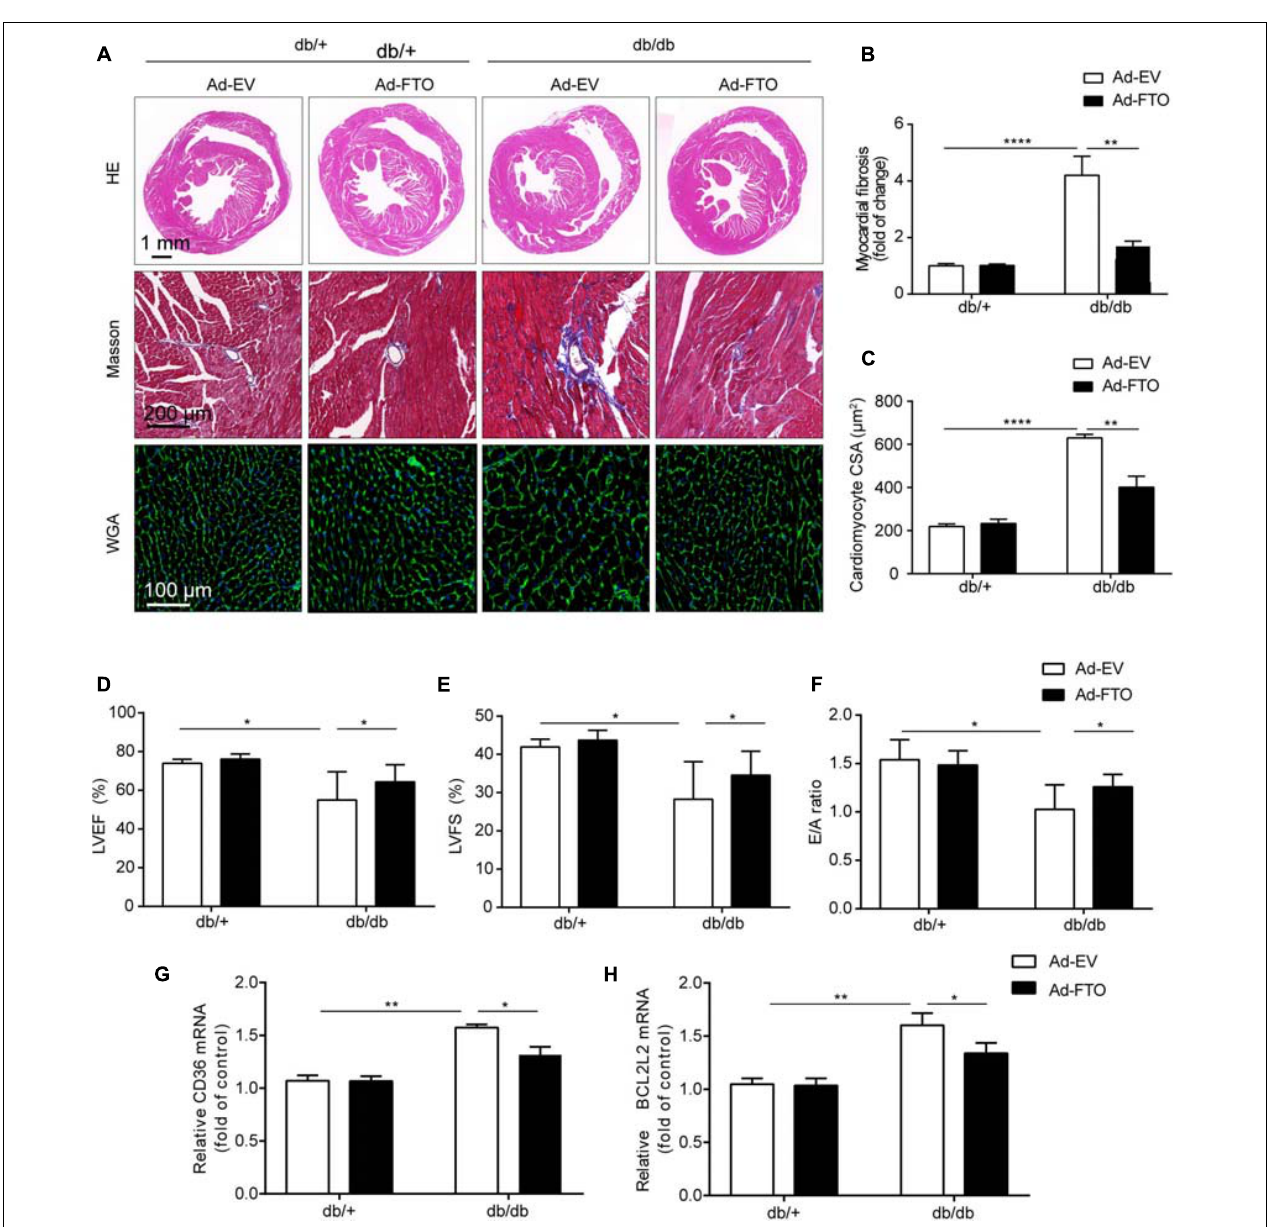
FIGURE 6 | Reconstitution of FTO alleviated cardiac hypertrophy and fibrosis in diabetic db/db mice. (A) The gross morphology of hearts stained with HE, Masson, and WGA. Scale bar, 2 mm (B,C) Quantitative analysis of interstitial fibrosis and cardiomyocyte cross-sectional area. Scale bar, 20 µ m. Mice with reconstituted FTO showed significantly increased ejection fraction (D) , fractional shortening (E) , and E/A ratio (F) . Mice with reconstituted FTO showed reduced Cd36 (G) and Bcl2l2 (H) expression, as determined by qPCR. Data are expressed as mean ± SD and were analyzed using the Student’s t -test. * P < 0.05; ** P < 0.01, **** P < 0.0001 vs. NC group ( n = 3 per